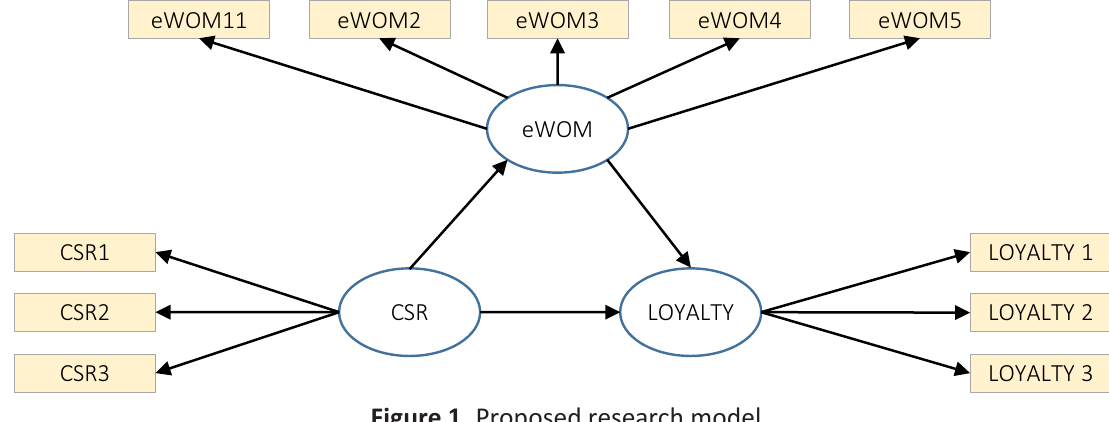
Figure 1. Proposed research